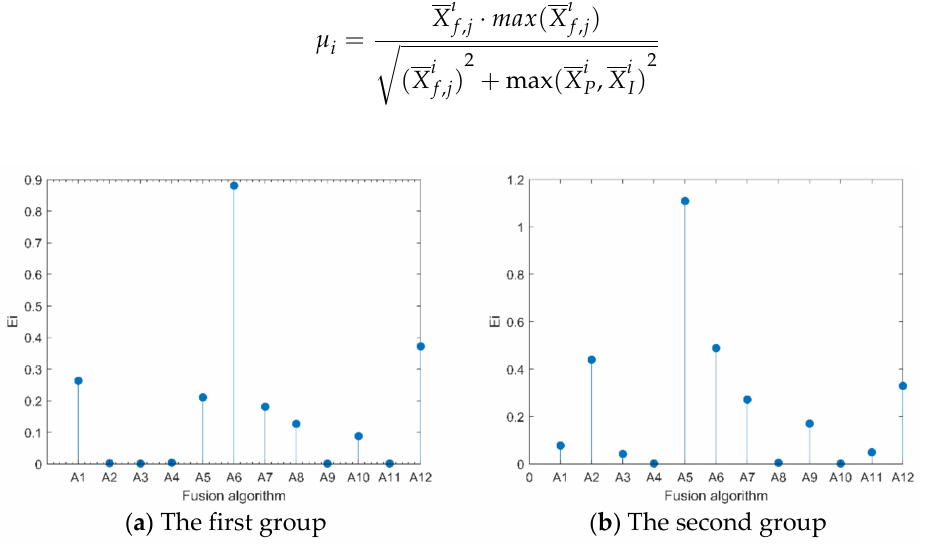
Figure 12. E i of different fusion algorithms of two